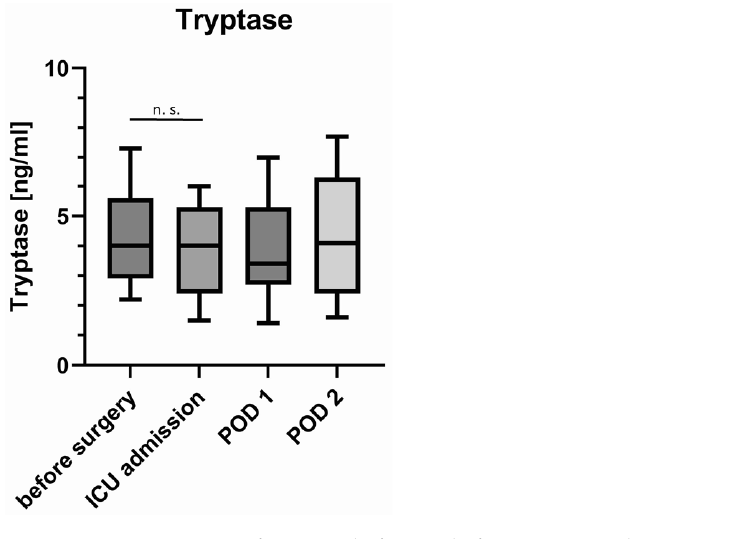
Figure 3. Concentration of tryptase before and after surgery and on postoperative days (POD) 1 and 2. Box – Whisker Plot (Tukey method). n. s. = p >